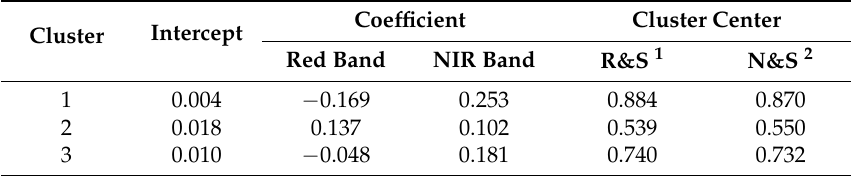
Table 3. The cluster centers and regression coefficients per